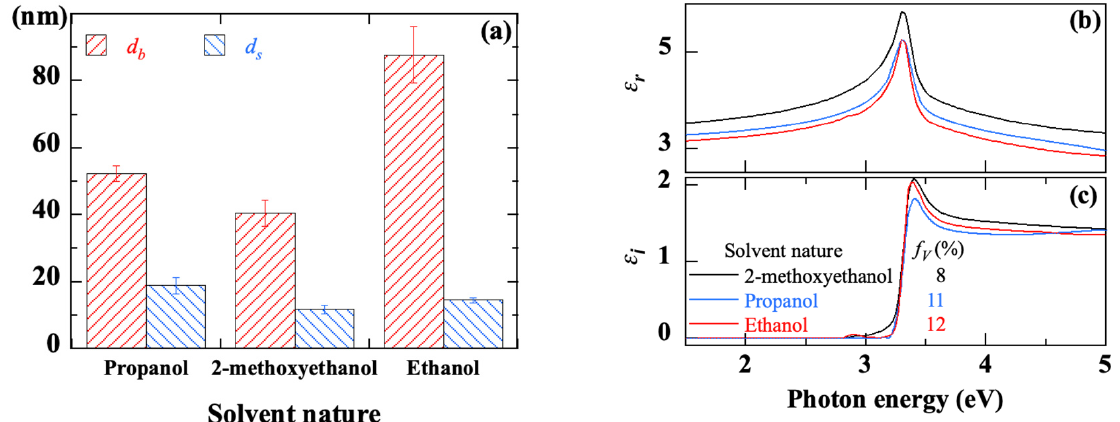
Figure 18. Thickness of the bulk layer ( a ) and the surface roughness ( b ), real ( c ) and imaginary ( d ) parts of the dielectric function extracted from SE measurements on sol-gel spin-coated ZnO thin films deposited with different solvents.